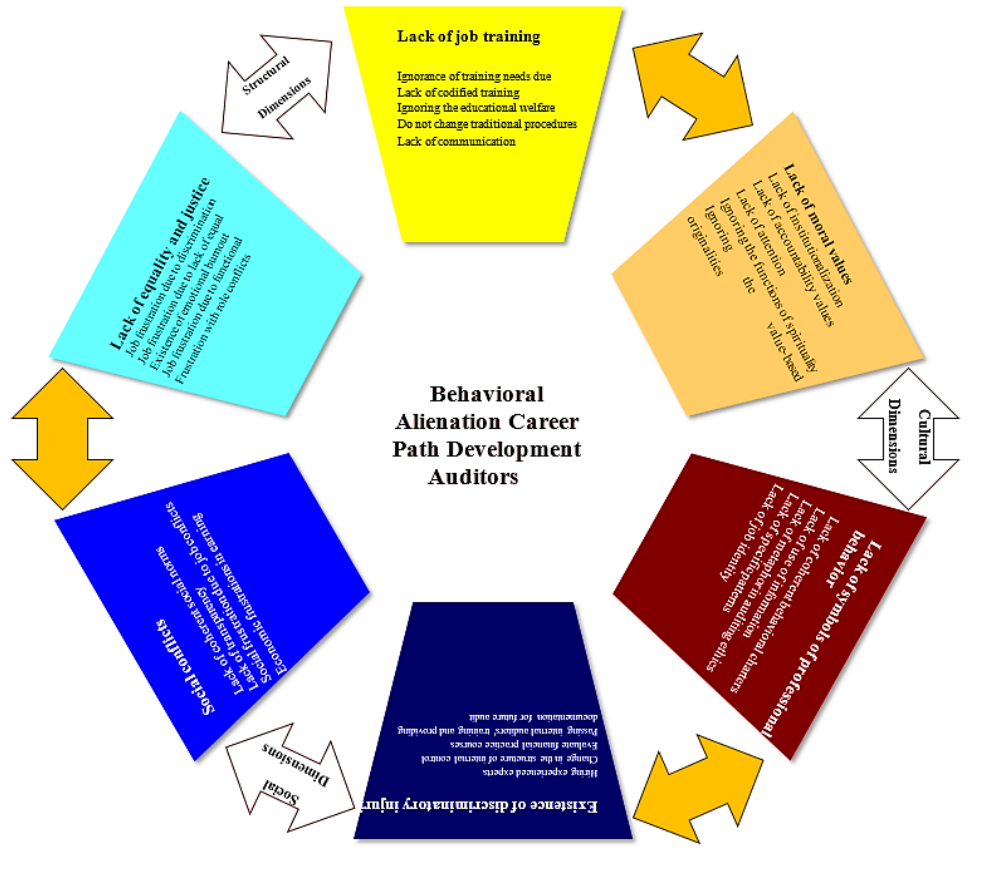
Figure 1. Theoretical framework of qualitative research